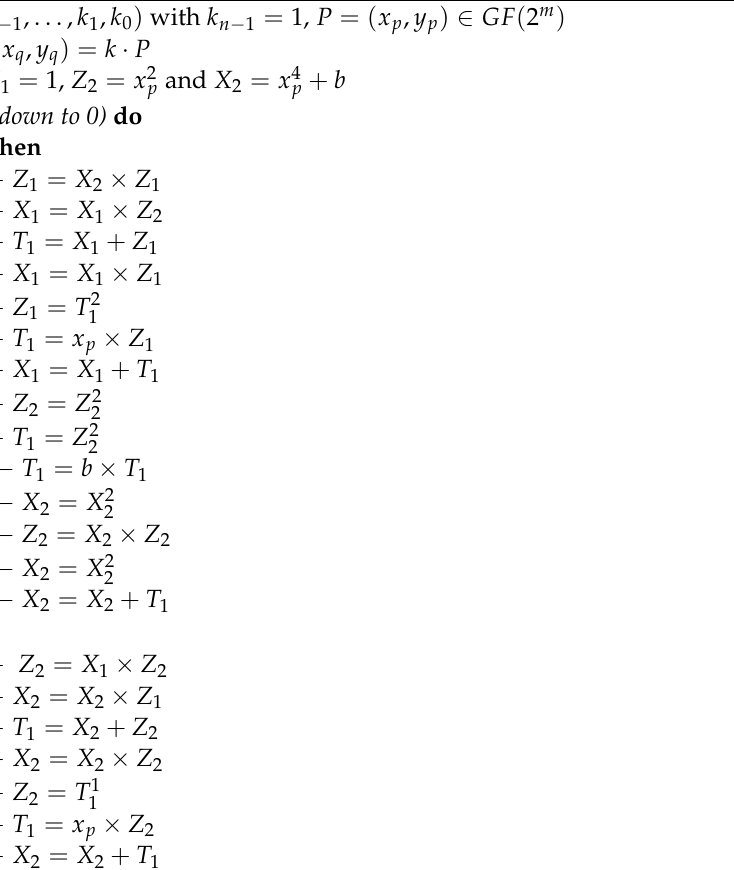
Algorithm 1: Montgomery PM Algorithm